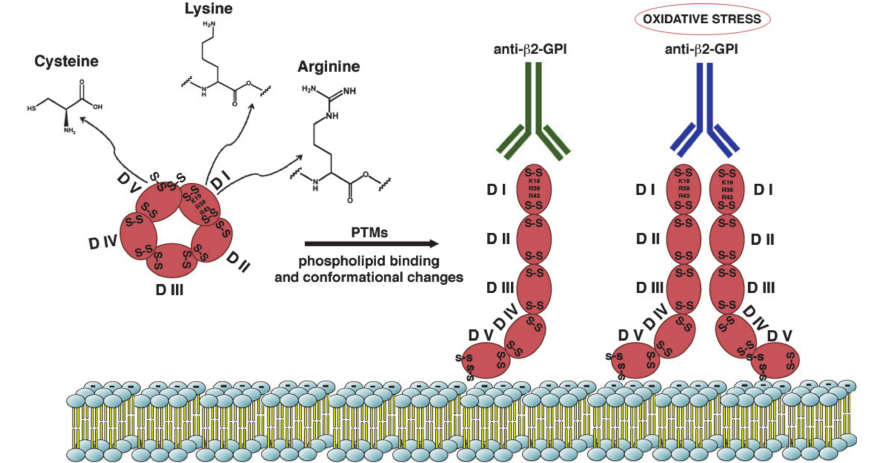
Figure 1. Schematic representation of β 2-GPI structure and conformation. β 2-GPI consist in five domains (I-V) with two disulfide bonds in each domain and an additional disulfide bond in domain V. Phospholipid binding by domain V and some PTMs of the protein result in a conformational change from the circular (closed) form to open configuration. This unfolded conformation may facilitate the exposition of “cryptic epitope” and autoantibodies binding. The amino acids most involved in the PTMs are Lysine, Arginine and Cysteine. Increased oxidative stress may alter the configuration of β 2-GPI to a dimeric form that enhance antibody a ffi